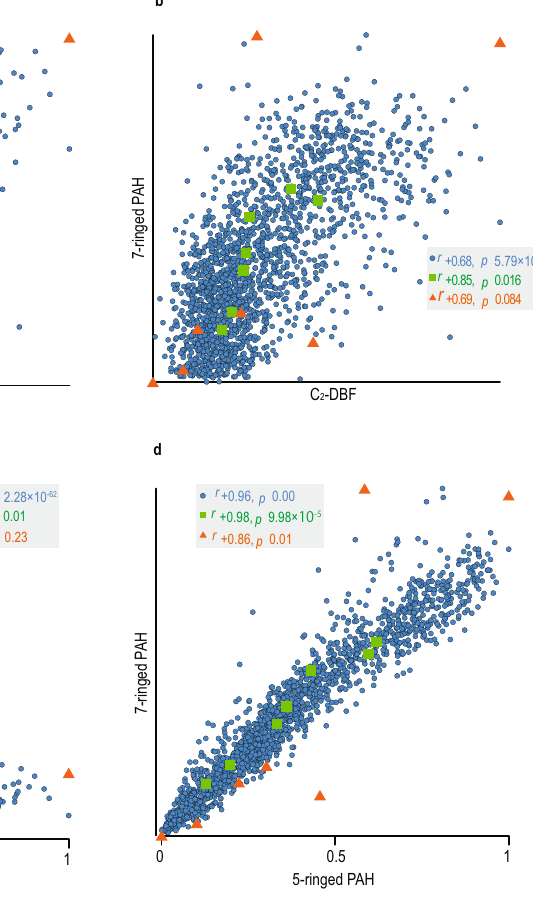
data.Pearson ’ s r values( r )and p values( p )areshownintheplots.ForMSIdata,the sample size is 1863, 1821, 1776, and 1823 in plots a – d, respectively. For MSI